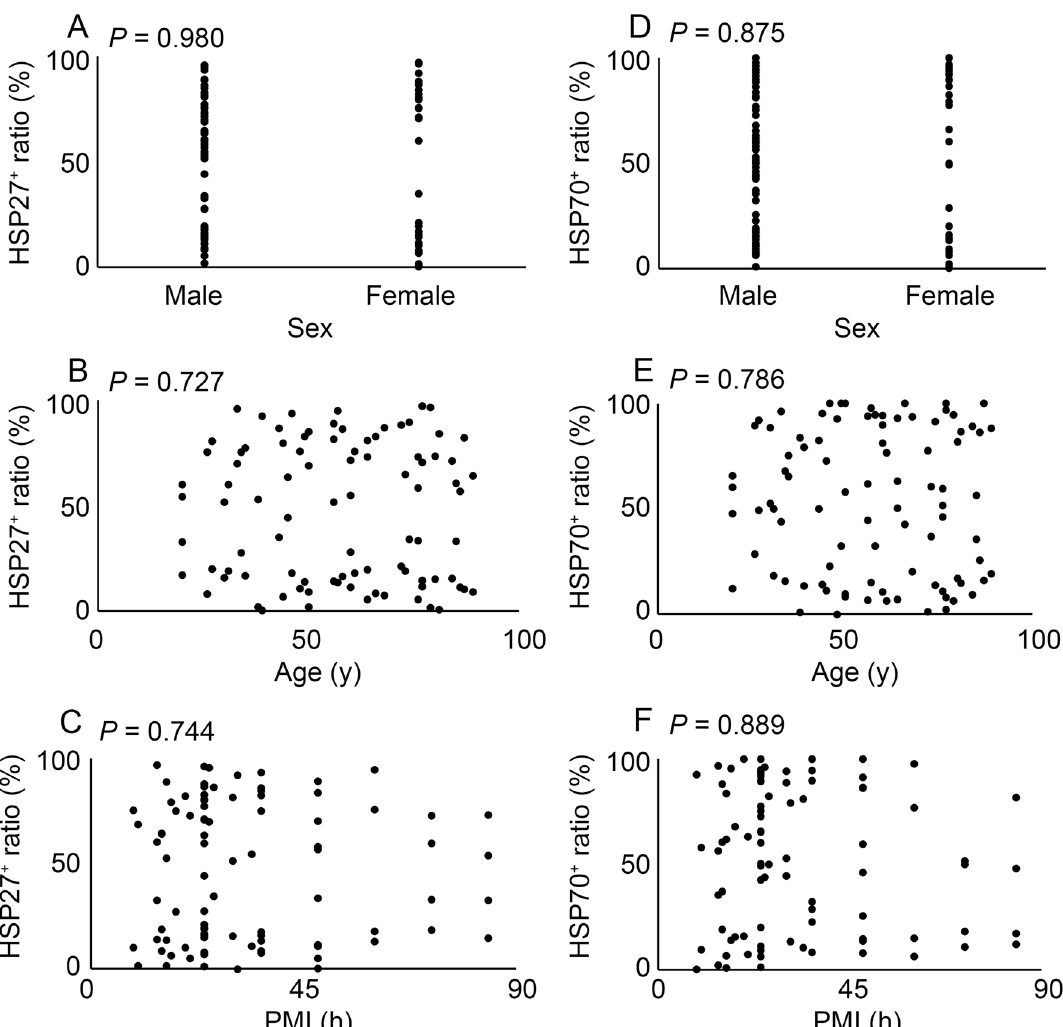
Figure 2. The relation between sex ( A , D ), age ( B , E ) or postmortem intervals (PMI) ( C , F ) and HSP27 expression ( A – C ) or HSP70 expression ( D – F ) in all cases. These results were obtained with Spearman’s correlation coefficient by rank